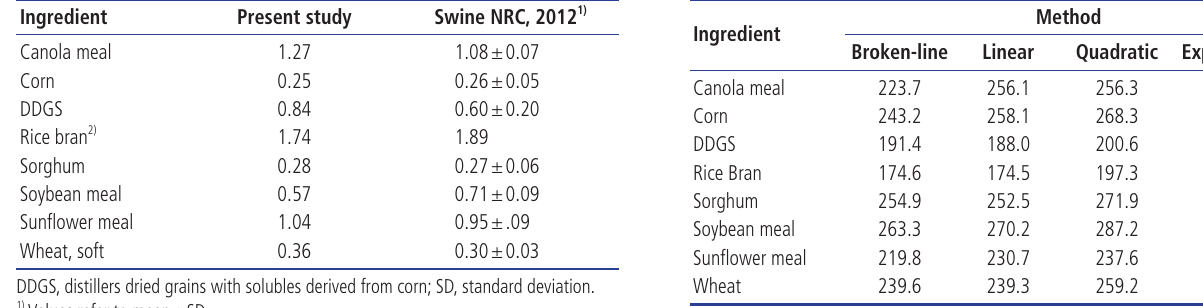
(Table 4). The STTD of P increased from 37.6% to 69.0% in CM,